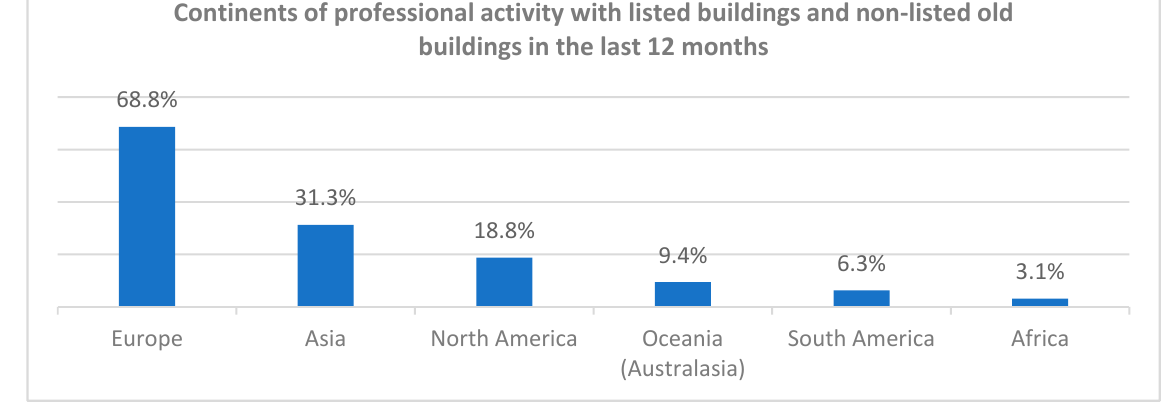
Figure 3. Continents of professional activity with listed buildings and non-listed old buildings in the last 12 months.